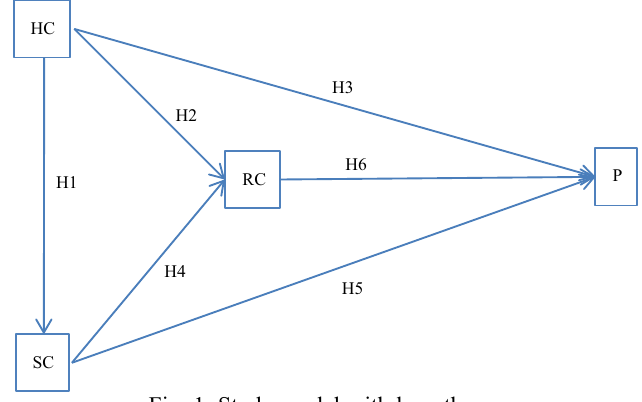
Fig. 1. Study model with